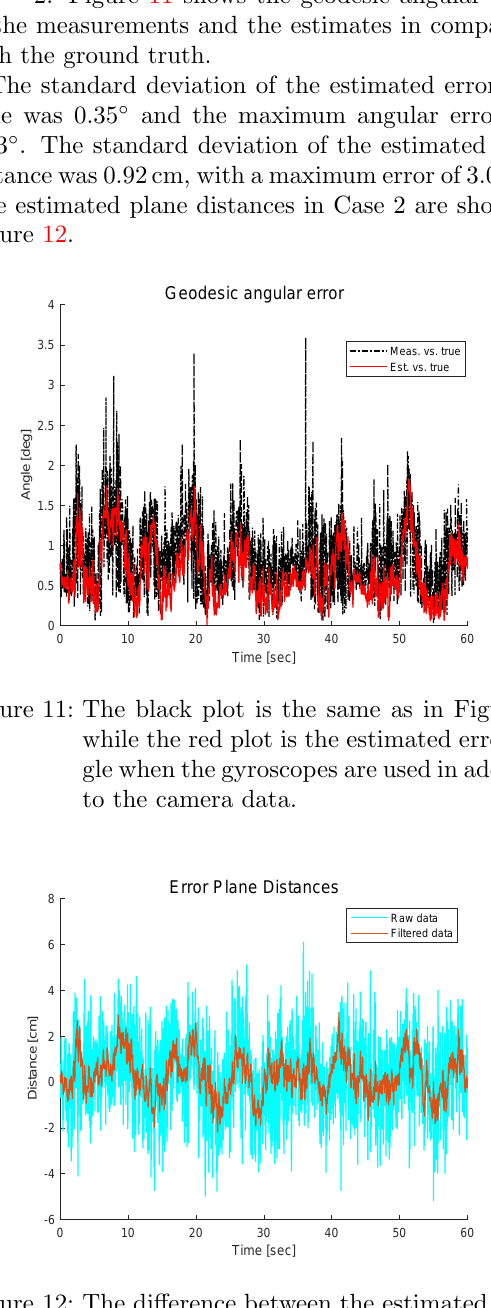
Figure 12: The difference between the estimated plane distances and the true values when gyro- scopes are utilized is not significant. This is because K 1 and K 2 remained unchanged from the first case, and the gyroscope data only altered the surface normal.